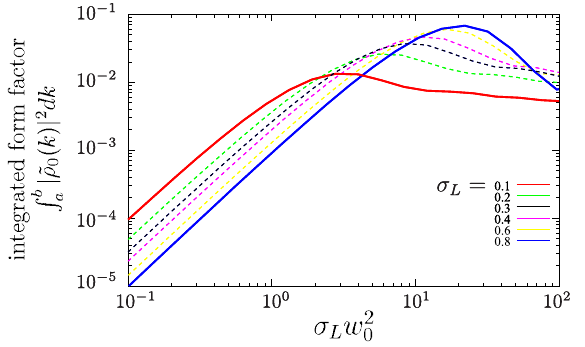
FIG. 5. Numerical calculation of the efficiency, represented in conditions similar to the experimental ones (Fig. 4). Note that dimensionless units are used. The quantity (cid:4) L w 2 0 is proportional to laser pulse energy. The integrated form factor is proportional to the terahertz pulse energy (and the bolometer signal). The laser pulse duration (cid:4) L is expressed in units of the electron bunch duration. The two thick full lines ( (cid:4) L ¼ 0 : 1 and (cid:4) L ¼ 0 : 8 ) approximately correspond to the pulse durations of Fig. 4 (28.5 ps, i.e., (cid:4) L ¼ 0 : 117 and 191 ps, i.e., (cid:4) L ¼ 0 : 78 ). The modulation wave number is k m ¼ 272 , which corresponds to 14 cm (cid:2) 1 . We took (cid:5) ¼ 0 , and other parameters are listed in Tables I and II.